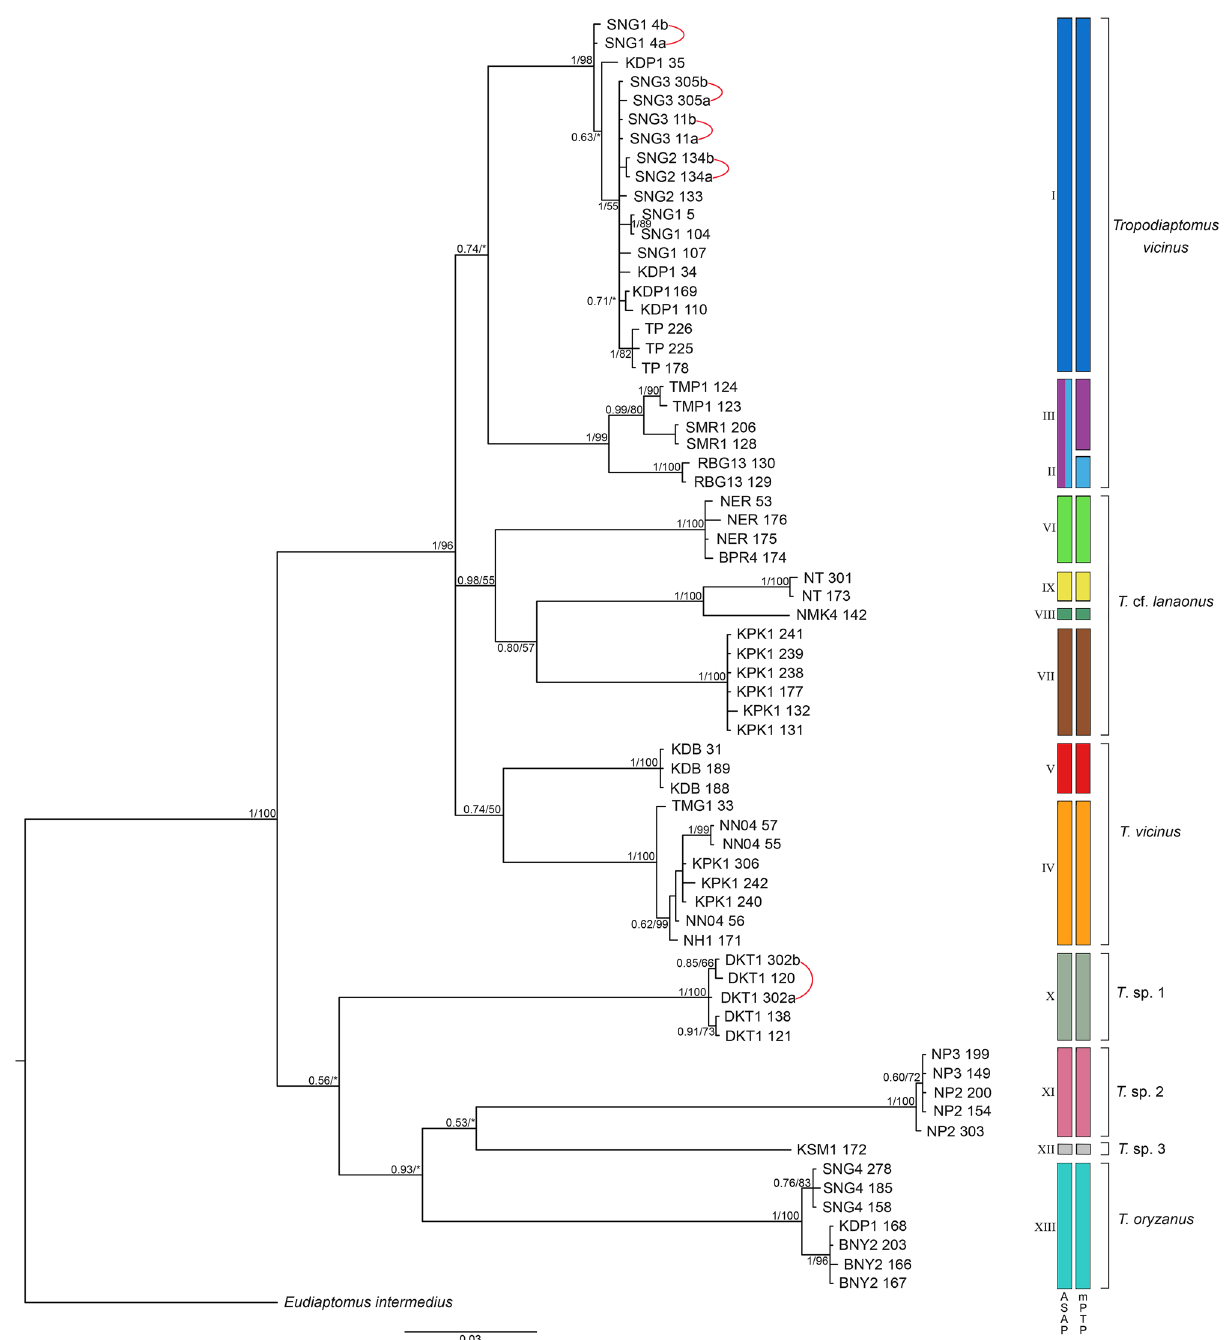
Figure 3. Bayesian phylogram (95% majority rule consensus tree) of Tropodiaptomus spp. based on the concatenated 12S-ITS2 dataset. Eudiaptomus intermedius was used as an outgroup to root the tree. Node statistical support is reported as nodal posterior probabilities (Bayesian Inference of phylogeny, BI)/bootstrap values (maximum likelihood, ML). Asterisks indicate support values lower than 50. Rectangles refer to MOTUs as indicated by ASAP or mPTP (see Supplementary Figs. S2, S3). Square brackets group the samples according to their morphological identification. The analyzed specimens are reported using the location and codes listed